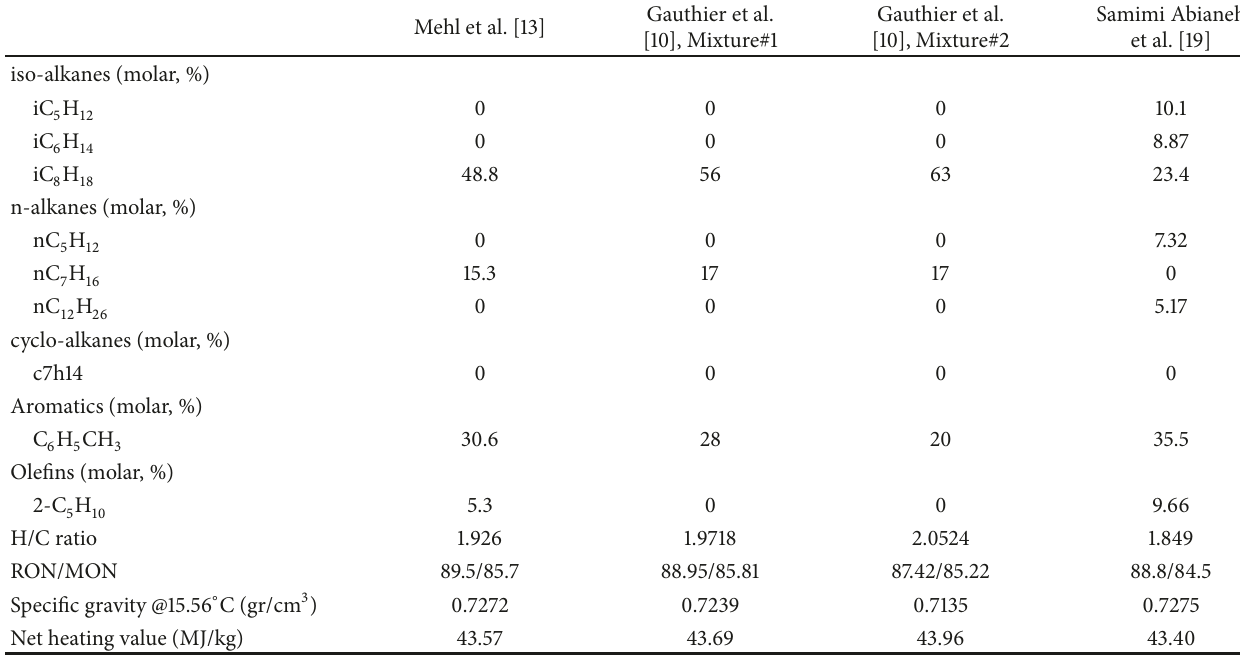
Table 12: Composition and properties of Mehl et al. [13], Gauthier et al. [10], and Samimi Abianeh et al. [19] surrogates (note: the